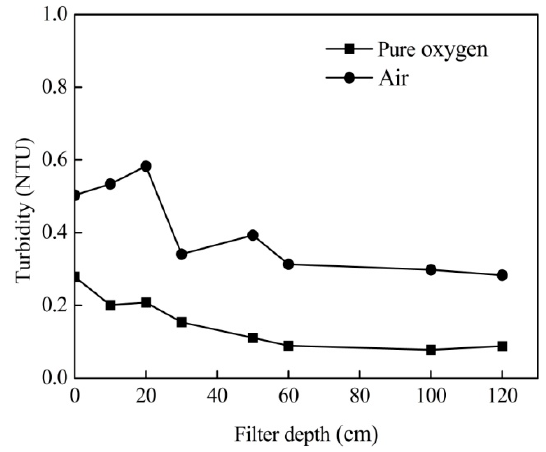
Figure 5. Concentration depth profiles of turbidity with aeration (40 mL/min pure oxygen and 100 mL/min compressed air).